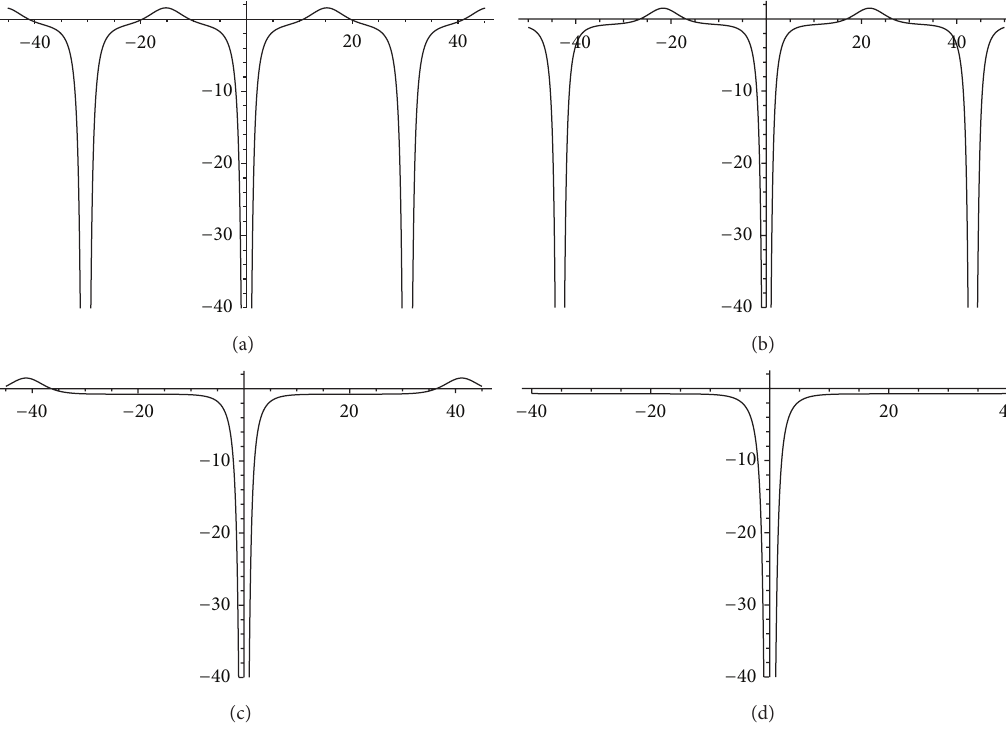
Figure 5: The varying process for graphs of 𝑢 13 (𝜉) when 𝑐 > 𝛼 and 𝑔 → 𝑔 0 + 0 where 𝛼 = 𝛽 = 𝛾 = 1 , 𝑐 = 2 , and (a) 𝑔 = 𝑔 0 + 1/5 . (b) + 10 −2 . (c) 𝑔 = 𝑔 + 10 −6 . (d) 𝑔 = 𝑔 + 10 −8 . 𝑔 = 𝑔 0 0 0